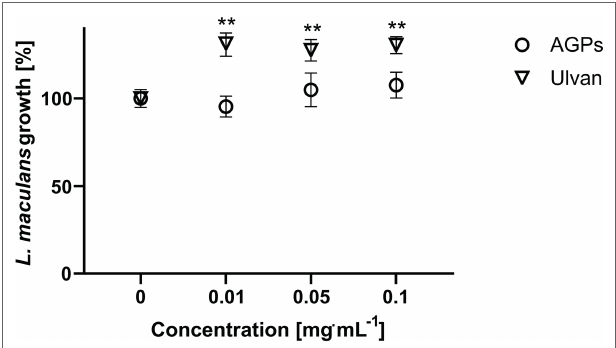
FIGURE 3 | Antifungal effect of AGP-like enriched fraction (AGPs) and ulvan on L. maculans growth. Spores of L. maculans tagged with GFP were cultivated with different concentrations of AGPs and ulvan extracted according to Yaich et al. (2013) (Ulvan) for 96 h in a microtitre plate. The growth of mycelium was quantified as an increase in GFP fluorescence. The data are presented as the mean ± SE values ( n = 6). Statistically significant differences determined by the t -test are marked either with an * p < 0.05 or ** p < 0.01, all samples were compared to the control (10 mM MES pH